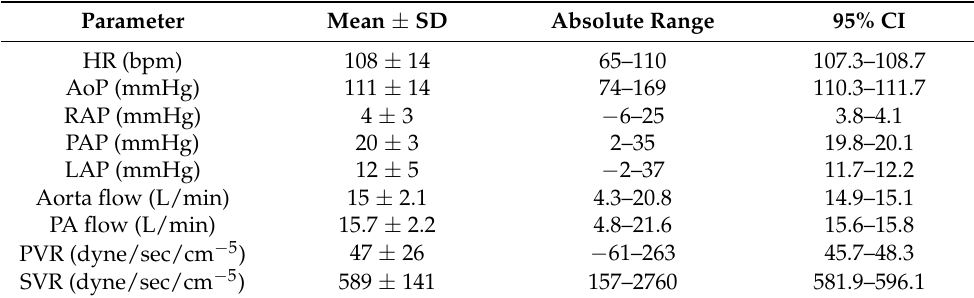
Table 1. Hemodynamic values at